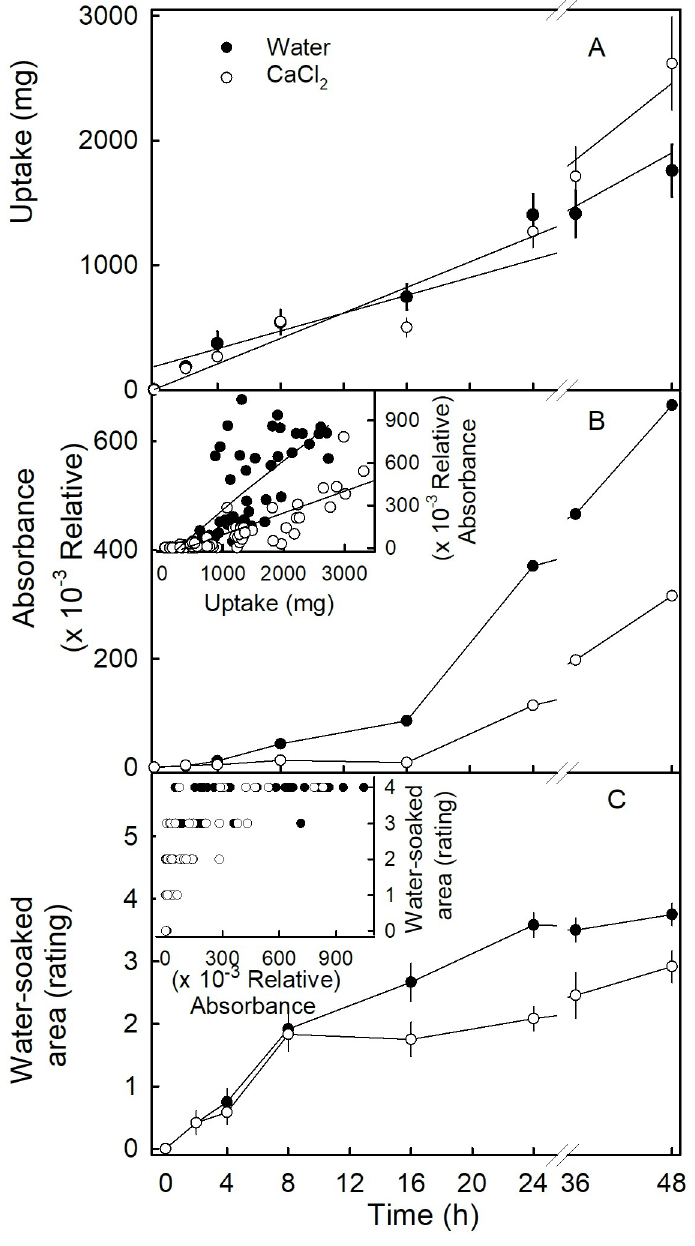
Fig 2. Time course of (A) water uptake, (B) leakage of anthocyanins as indexed by the absorbance (520 nm) of the incubation solution; and (C) change in area affected by water soaking. Inset (B): Relationship between anthocyanin leakage and water uptake, Inset (C): Relationship between water-soaked area and anthocyanin leakage. Strawberry fruit ‘Clery’ was incubated in deionized water or in 10 mM CaCl 2